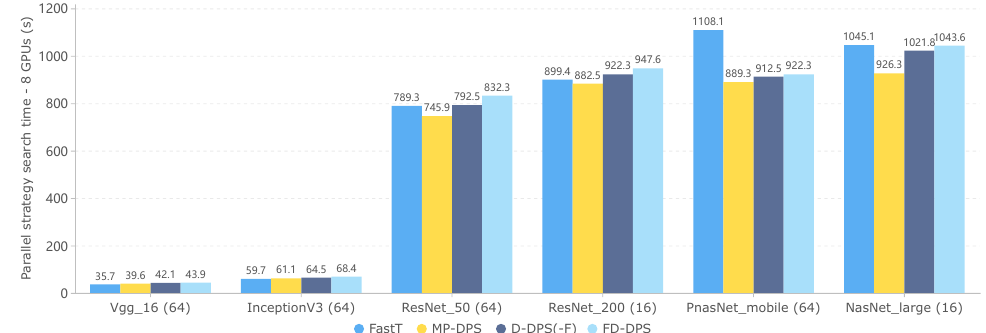
Figure 5. The optimal strategy search time comparison of FD-DPS and